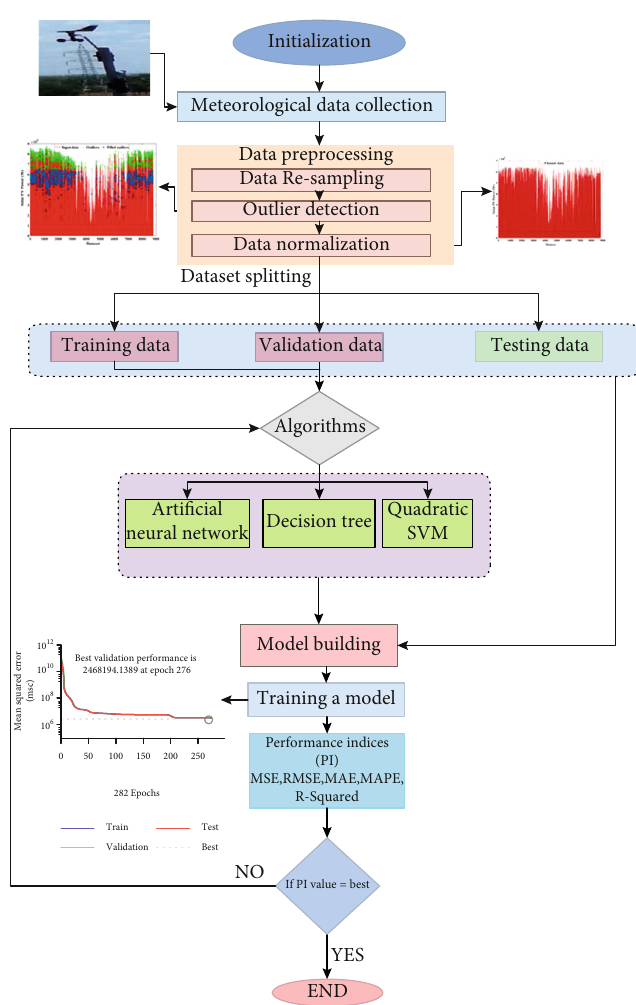
Figure 1: Flow chart of the short-term power prediction of the building integrated.